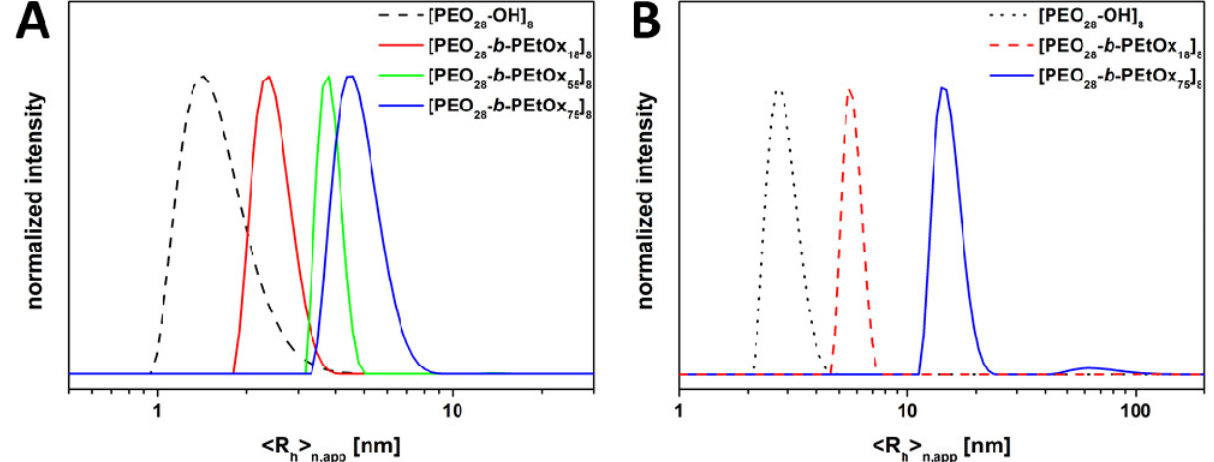
Figure 6. DLS CONTIN plot for “arm-first” approach stars in different solvents: in THF: [PEO -OH] (dashed black line, <R > = 1.5 nm), [PEO - b -PEtOx ] (red line, 28 8 h n,app 28 18 8 <R > = 2.5 nm), [PEO - b -PEtOx ] (green line, <R > = 4 nm) and h n,app 28 55 8 h n,app [PEO - b -PEtOx ] (blue line, <R > = 5 nm) (2 g L -1 ) ( A ); in water [PEO -OH] 28 75 8 h n,app 28 8 > = 3 nm), [PEO - b -PEtOx ] (red dashed, <R > = 6 nm) (dotted black line, <R h n,app 28 18 8 h n,app